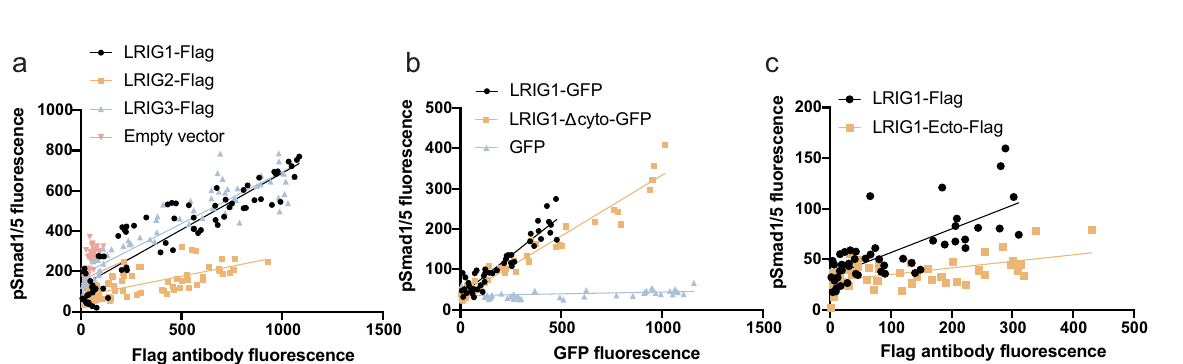
Fig. 4 LRIG1 and LRIG3 promote BMP signaling. a Different LRIG protein expression levels were induced in LRIG -inducible MEFs by treating the cells with different concentrations of the inducer doxycycline. Thereafter, the cells were stimulated with 2.5 ng/ml BMP4 for one hour followed by coimmunocyto fl uorescence analyses of nuclear pSmad1/5 and the FLAG-epitope present as a tag on the induced LRIG proteins. Correlation plots of phosphorylated Smad1/5 versus the FLAG-LRIG protein expression levels are shown. Fitted lines indicate the linear relationship with pSmad1/5 for each LRIG protein. Pearson ’ s correlation coef fi cients for the respective genes were LRIG1, 0.9162; LRIG2, 0.6939; LRIG3, 0.9251; and empty vector, 0.1659. Shown are three experimental repeats using three biological replicates. b Lrig -null MEFs were transfected with a full-length LRIG1-GFP fusion protein (LRIG1-GFP), an LRIG1-GFP fusion protein variant lacking the cytosolic domain of LRIG1 (LRIG1- Δ cyto-GFP), or empty vector (GFP) as a transfection control. Thereafter, the cells were stimulated with 20 ng/ml of BMP4 for 20 min followed by coimmunocyto fl uorescence analyses of nuclear pSmad1/5 and the green fl uorescence from GFP fusion proteins or control GFP. The correlation plots between pSmad1/5 and GFP fl uorescence are shown. The fi tted lines indicate the linear relationship to pSmad1/5 for the respective construct. Pearson ’ s correlation coef fi cients for the respective constructs were